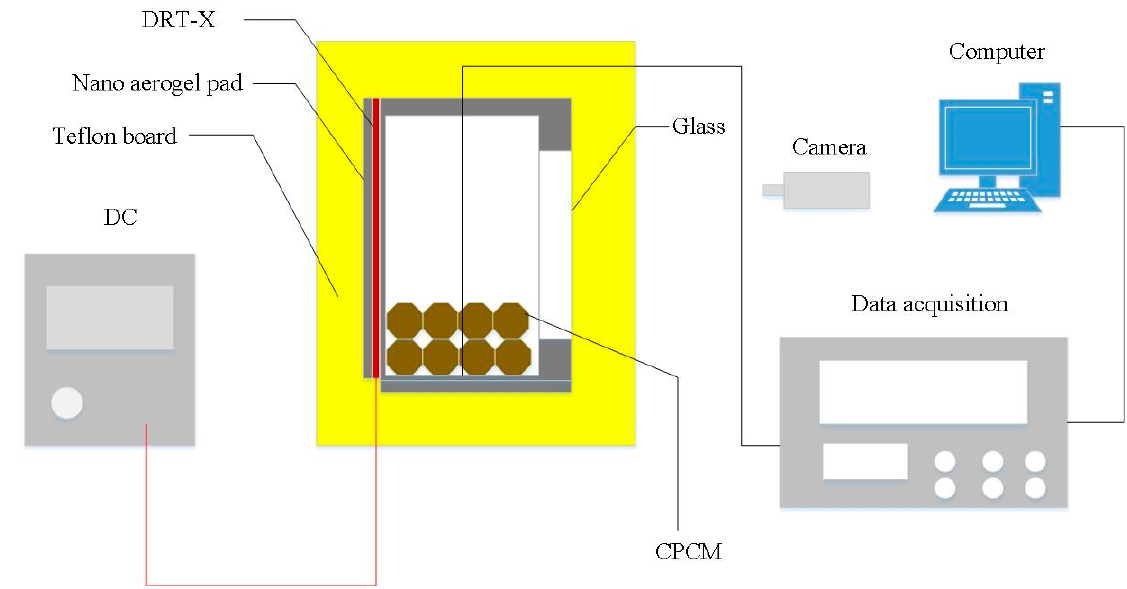
Figure 2. Performance testing diagram of the paraffin/copper foam composite PCMs.